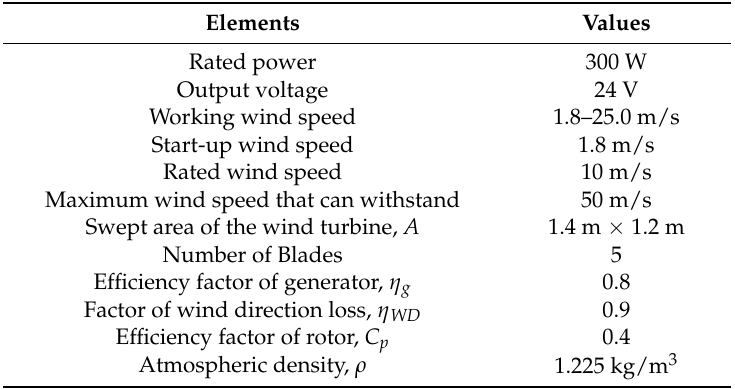
Table 8. Parameters of the wind turbine. Reprint with permission [47]; 2016, Elsevier.